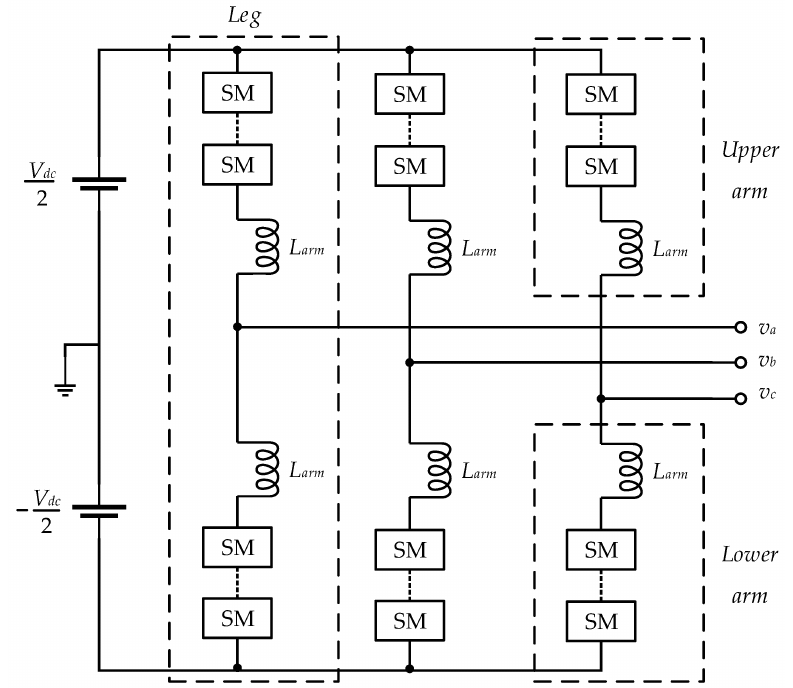
Figure 3. Basic configuration of modular multilevel